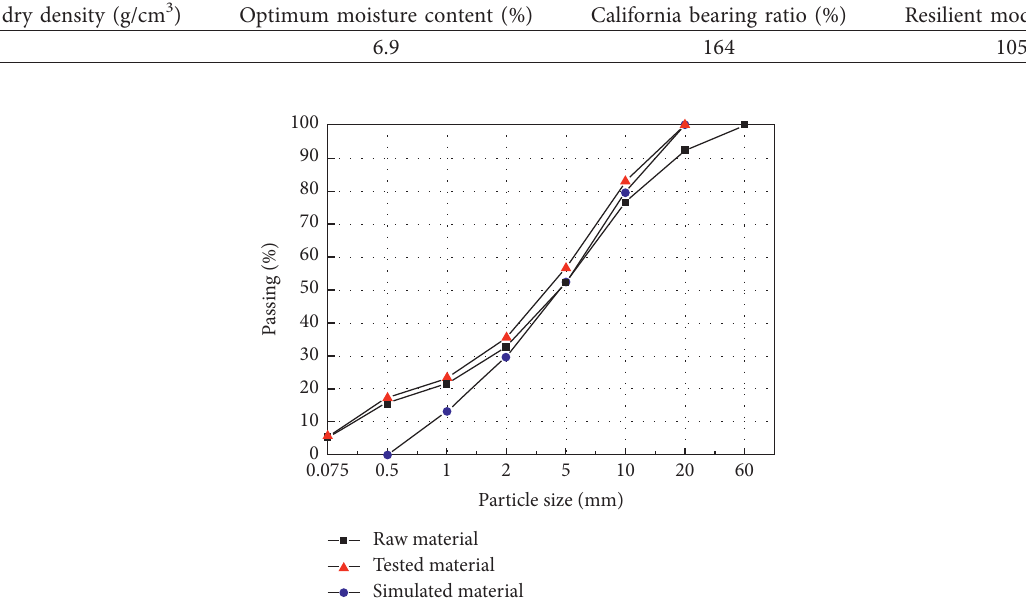
Table 1: Basic physical and mechanical properties of coarse-grained soil.